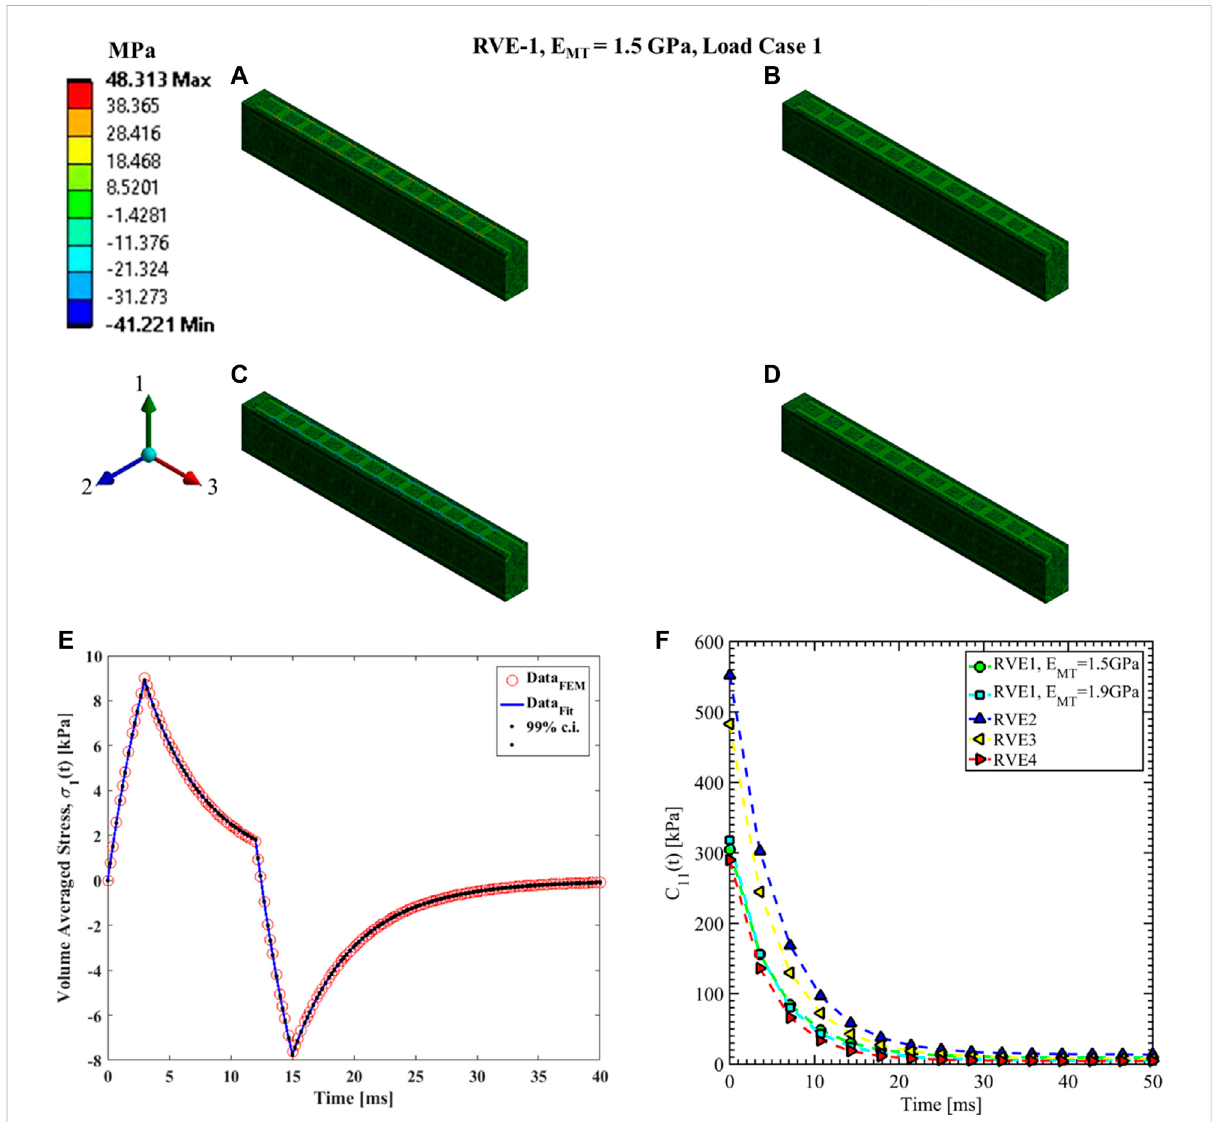
FIGURE 7 Contourplotoftheelementnormalstressindirection1( [ σ 1 ( t )] ρ fromEq.16). C 11 ( t ) estimationfortheRVE-1with E MT (cid:2) 1 . 5 GPa byimposingthe load case 1. (A) t 1 (cid:2) 3 ms , δ 1 ( t 1 ) (cid:2) 3 nm (B) t 2 (cid:2) 12 ms , δ 1 ( t 2 ) (cid:2) 3 nm (C) t 3 (cid:2) 15 ms , δ 1 ( t 3 ) (cid:2) 0 nm (D) t 4 (cid:2) 40 ms , δ 1 ( t 4 ) (cid:2) 0 nm . (E) Nonlinear regression data fi t with 99% con fi dence interval (c.i.) is shown for volume averaged normal stress in direction 1 for RVE-1, E MT (cid:2) 1 . 5 GPa for load case 1. (F) Comparison of C 11 ( t ) for different